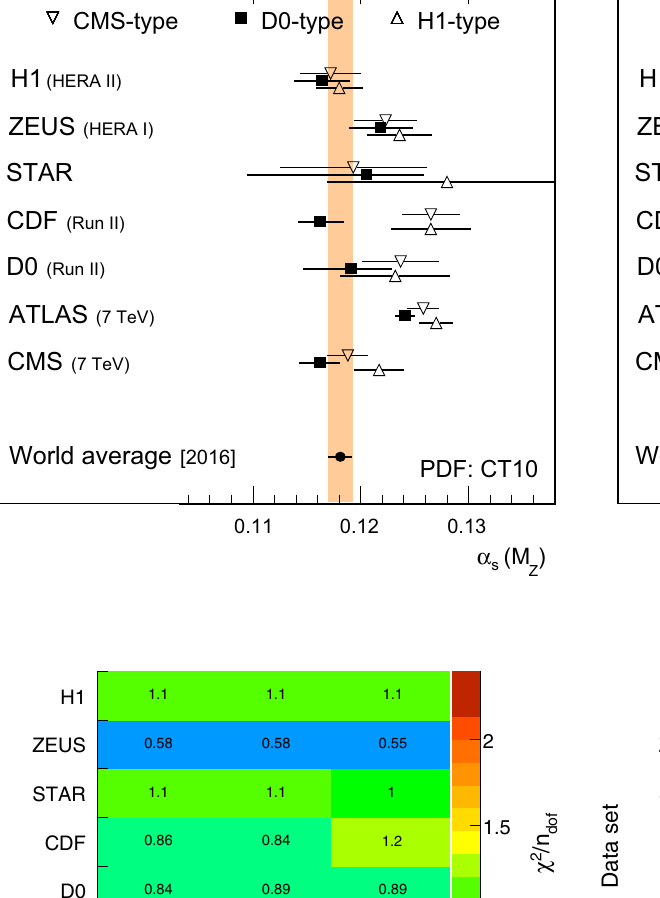
bottom row displays the values of χ 2 / n dof for each fit using the CT10 (left) or MSTW2008 PDF set (right). The colours illustrate the values of χ 2 / n dof . For the STAR data and the MSTW2008 PDF set no local minimum was found in case of the CMS-type and D0-type fits (blank areas)